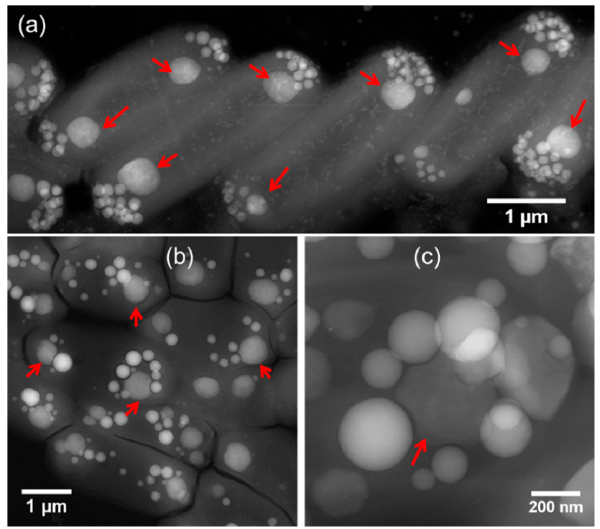
Figure 5. Spatial relationships between carbonate and polyphosphate inclusions within Ca .